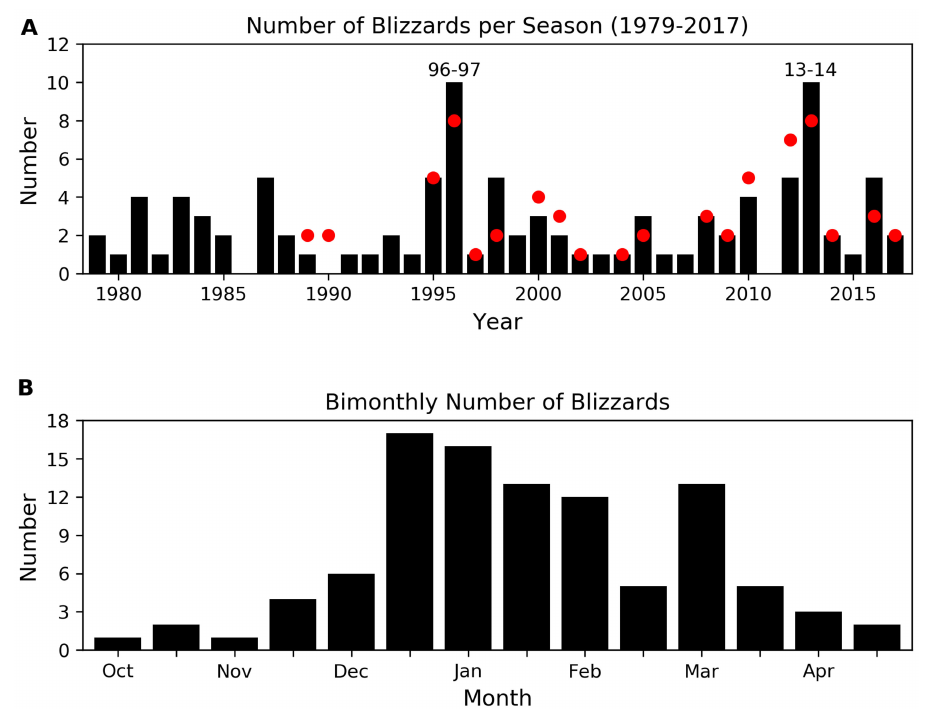
Figure 3. ( a ) Annual and ( b ) bimonthly number of Storm Data blizzards for the winter seasons of 1979–1980 and 2017–2018. Named blizzards by the Grand Forks Herald are provided by the red dots in panel ( a